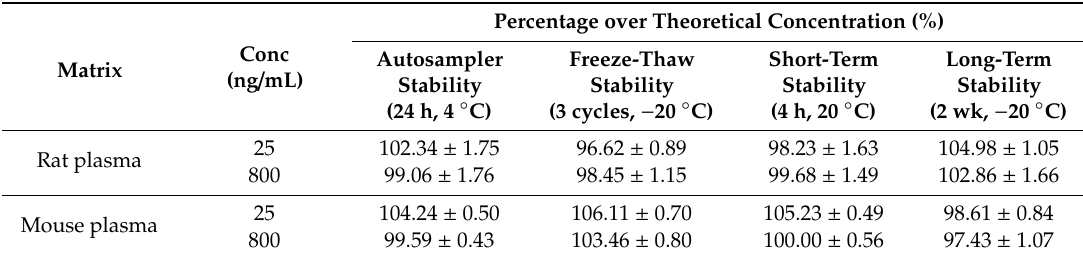
Table 4. Stability of desoxo-narchinol A in blank rat and mouse plasma ( n = 5).